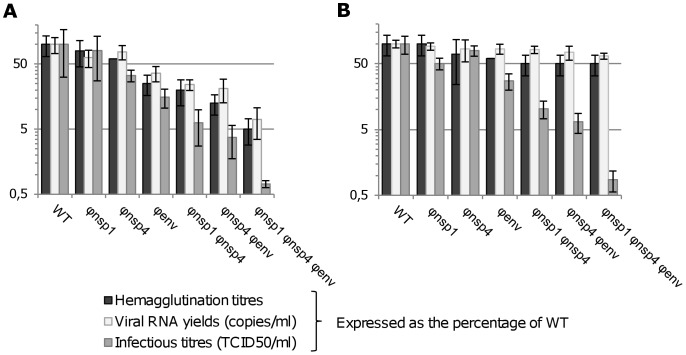
Comparison of the results from haemagglutination, real time RT-PCR and TCID50 assays.To assess the relationship between viral RNA yields and the number of viral particles in the cell supernatants, the results of quantitative RT-PCR, TCID50 and haemagglutination assay were compared. An estimated MOI of 5 was used to infect confluent Vero (A) or C6/36 (B) cells. Cells were washed after the infection and cell supernatants were sampled at 16 hours pi. Clarified (centrifugation) cell supernatants were used to perform haemagglutination, real time RT-PCR and TCID50 assays. Results are expressed in the graphs as percentage of WT and are the mean/standard deviation of three independent experiments.